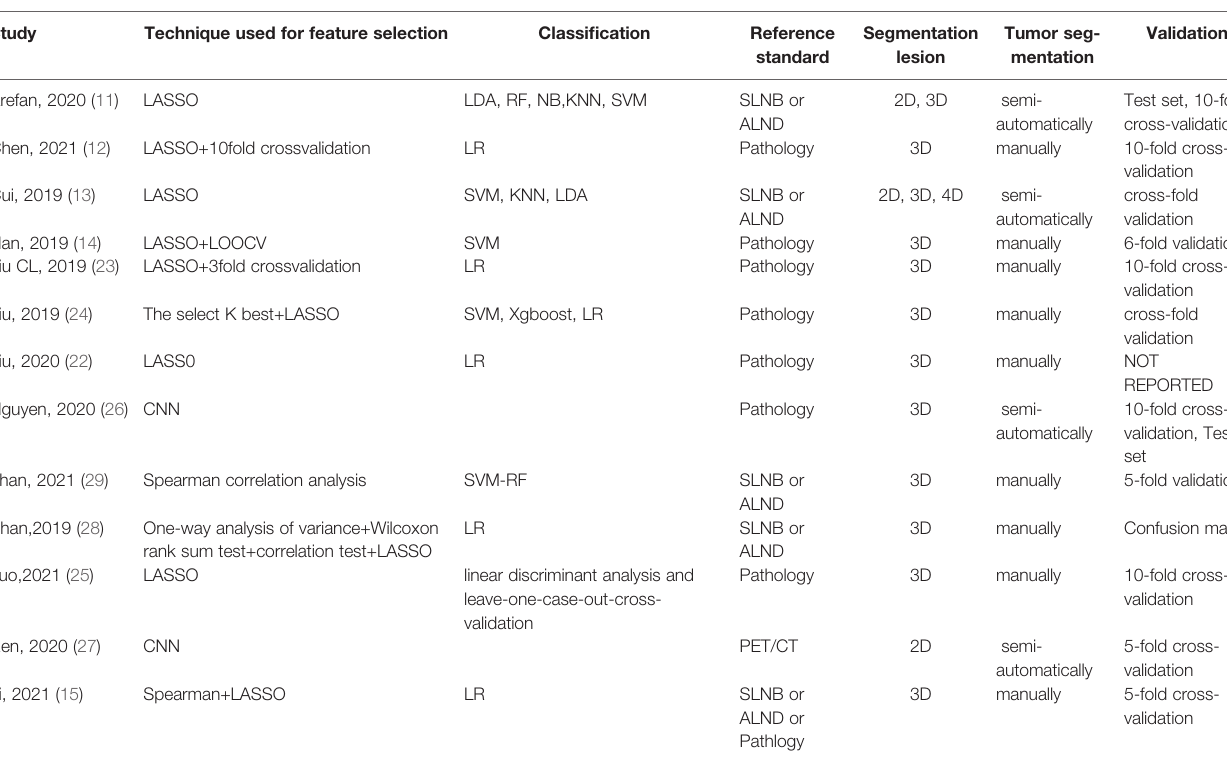
TABLE 3 | Baseline characteristic of included studies